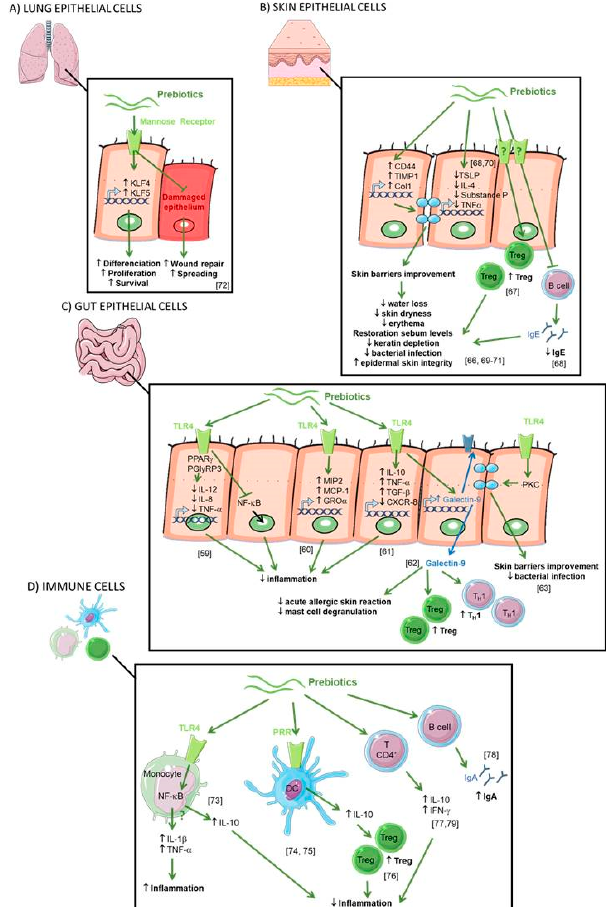
Figure 4. Direct effects of prebiotics. ( A ) Direct effect of prebiotics on lung epithelial cells. Mannan prebiotic stimulates cell spreading and facilitates wound repair in damaged human bronchial epithelium, involving mannose receptors. Prebiotics also increases expression and activation of Krüppel-like factors (KLFs) inducing cell differentiation, survival, and proliferation. ( B ) Direct effect of prebiotics on skin epithelial cells. Prebiotics supplementation improved water retention and prevented erythema via the expression of CD44, metallopeptidase inhibitor 1 (TIMP)-1, and collagen type 1(Col1) improving the skin’s barrier properties. Prebiotics suppress overproductions of thymic stromal lymphopoietin (TSLP), substance P, IL-10, IL-4, and tumor necrosis factor (TNF)-a leading to reduced transepidermal water loss and skin dryness, prevention of keratin depletion, improvement of biophysical parameters of the epidermis, restoration of skin sebum levels, and limitation of bacterial infection. Prebiotics increase CD4+ Foxp3+ Treg in skin lymph nodes and prevent germline class-switching and IgE production. ( C ) Direct effect of prebiotics on gut epithelial cells. Prebiotics are Toll like receptor 4 (TLR4) ligands in IEC. Prebiotics induce a range of anti-inflammatory cytokines and reduce pro-inflammatory cytokines to inhibit gut inflammation. Prebiotics enhance galectin-9 expression correlated with reduced acute allergic skin reaction and mast cell degranulation and promoted Th1 and Treg responses. Prebiotics directly promoted barrier integrity to prevent pathogen-induced barrier disruptions involving the induction of protein kinase C (PKC). (D) Direct e ff ect of prebiotics on immune cells. Prebiotics induce both the secretion of anti-inflammatory (IL-10) and pro-inflammatory (IL-1 β and TNF- α ) cytokines by blood monocytes due to the activation of the NF-kB pathway by the binding of TLR4. Prebiotics bind pathogen recognition receptor (PRRs) on the surface of DCs inducing IL-10 secretion and Treg cells. Prebiotics enhance the secretion of IL-10 and interferon- γ (IFN- γ ) by CD4 + T cells and